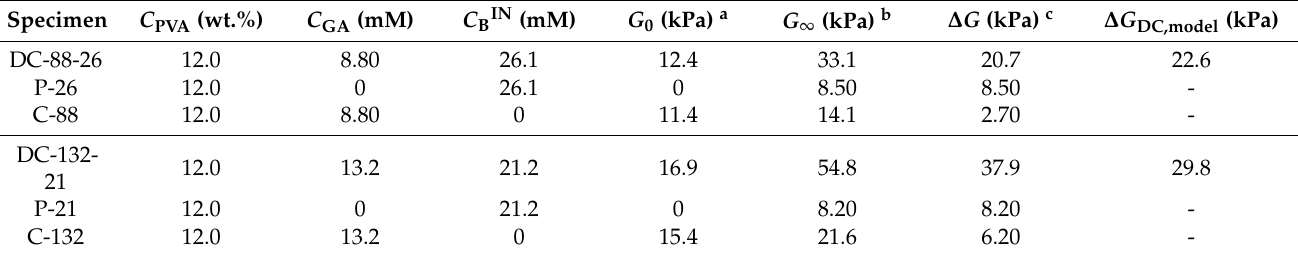
Table 2. Characteristic parameters of